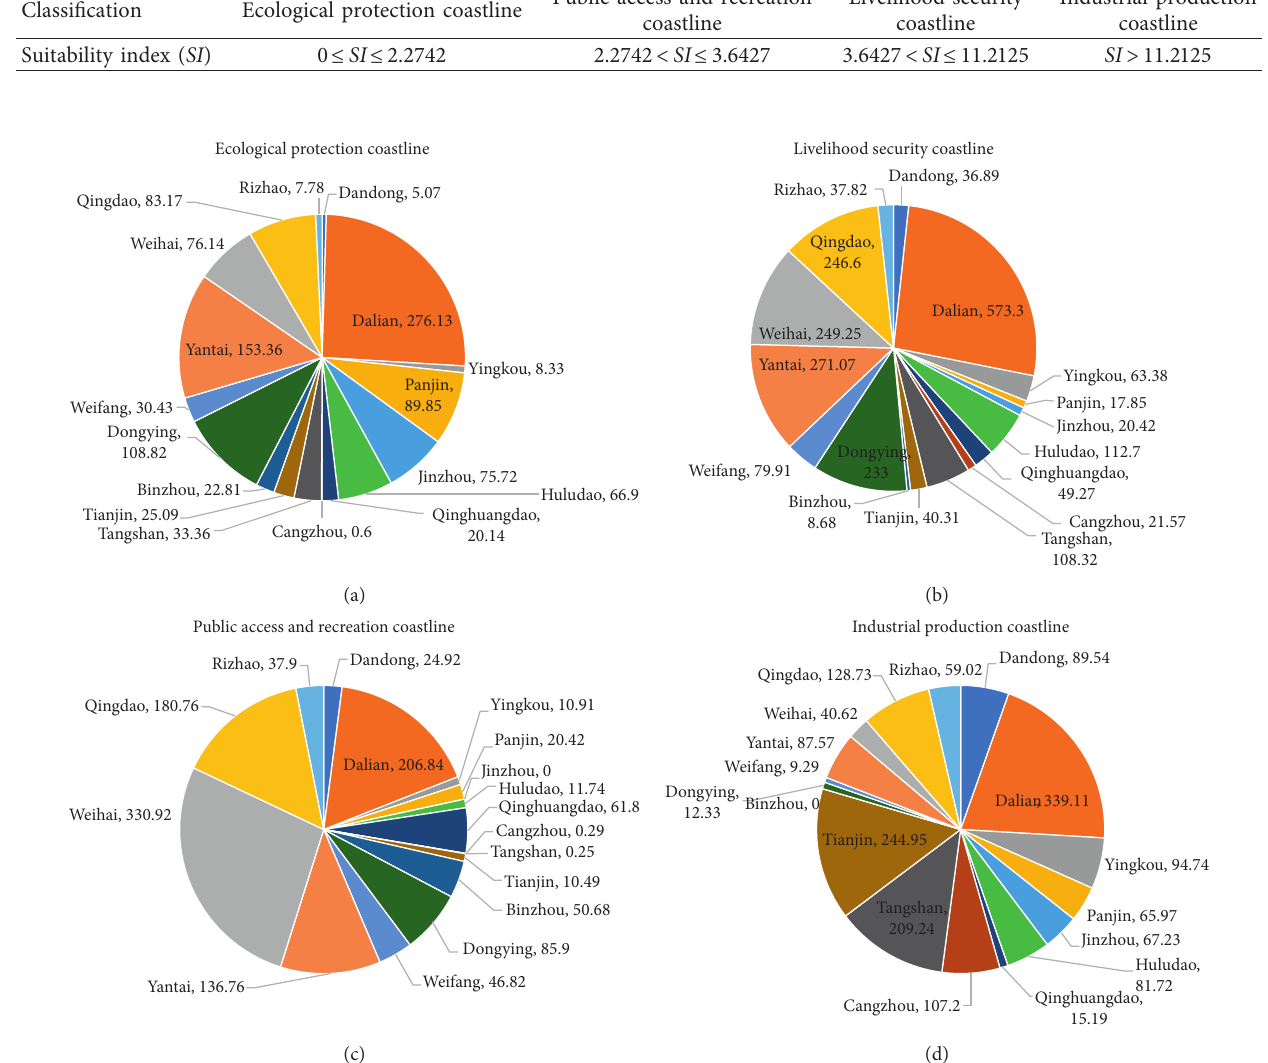
Figure 2: Length and distribution of all types for comprehensive utilization at the Bohai Rim